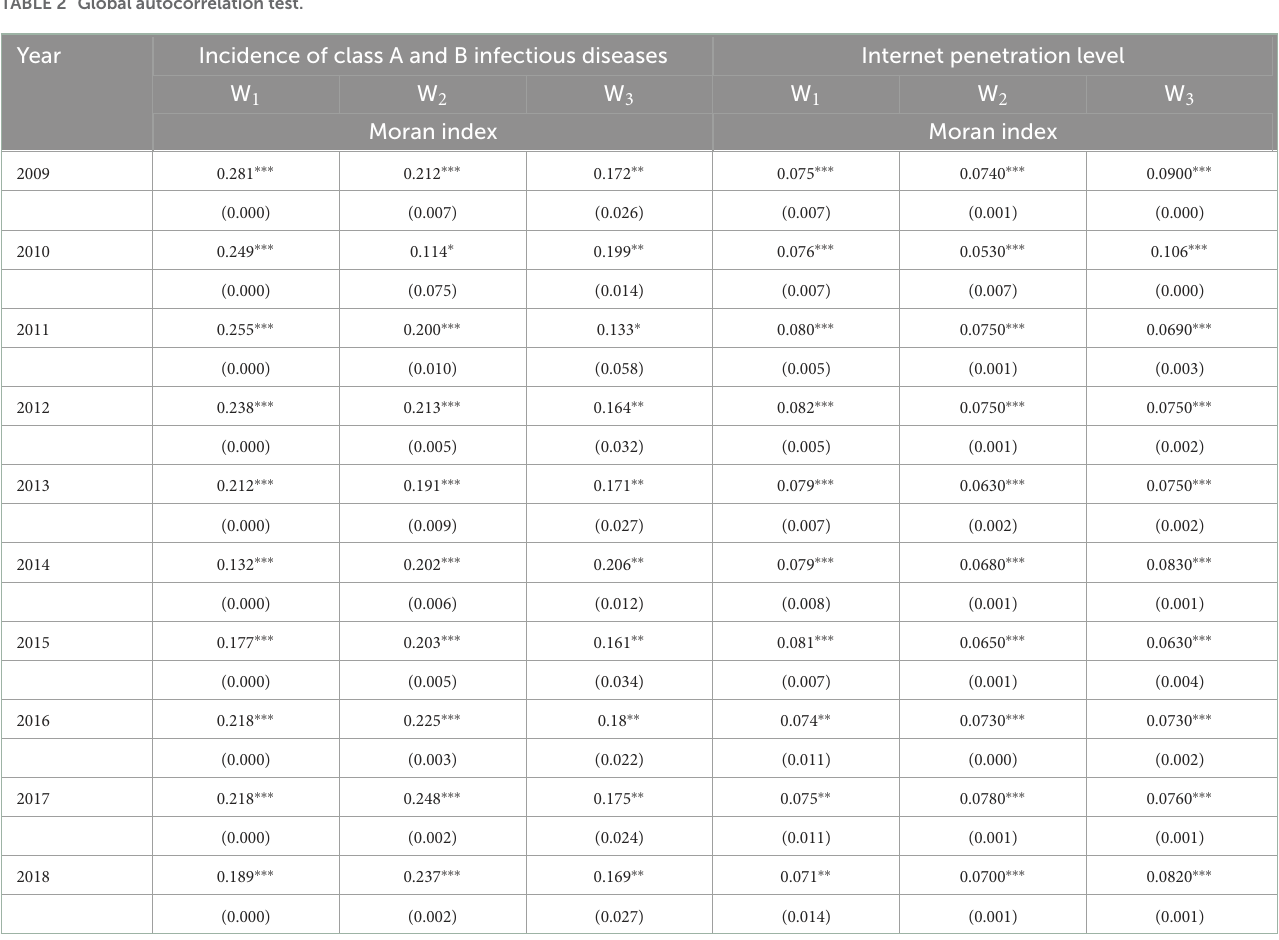
TABLE 2 Global autocorrelation